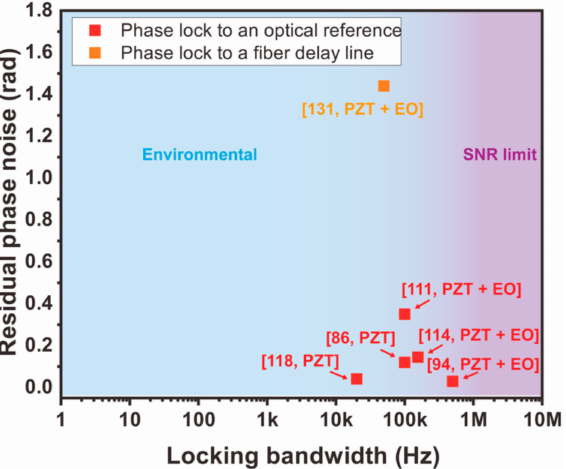
Figure 8. Representative performance of comb-line phase noise reduction methods presenting as locking bandwidth vs. residual phase noise. The different color-shaded regions indicate noise of free-running comb originating from environmental noise and SNR